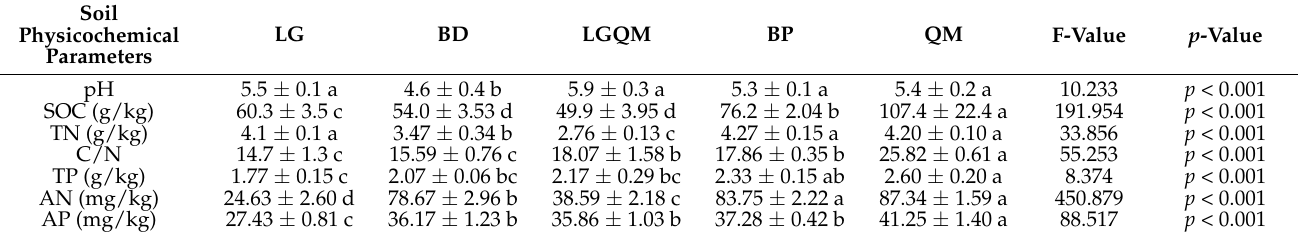
Table 2. Physicochemical characteristics of the soil samples in the five restored forest types. Soil